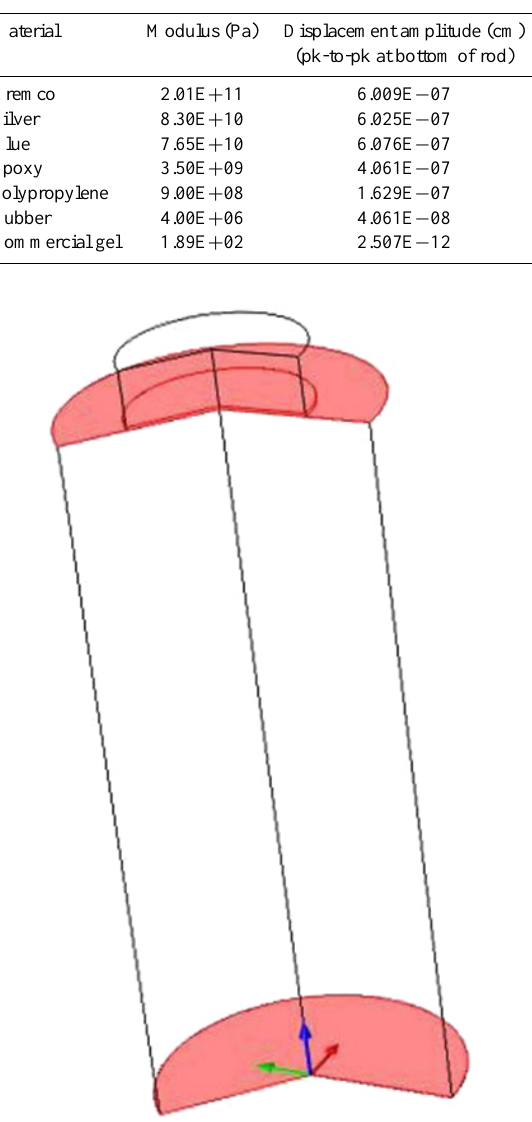
Figure 8. The three planes used to find the average displacement over the area of each vs. time.